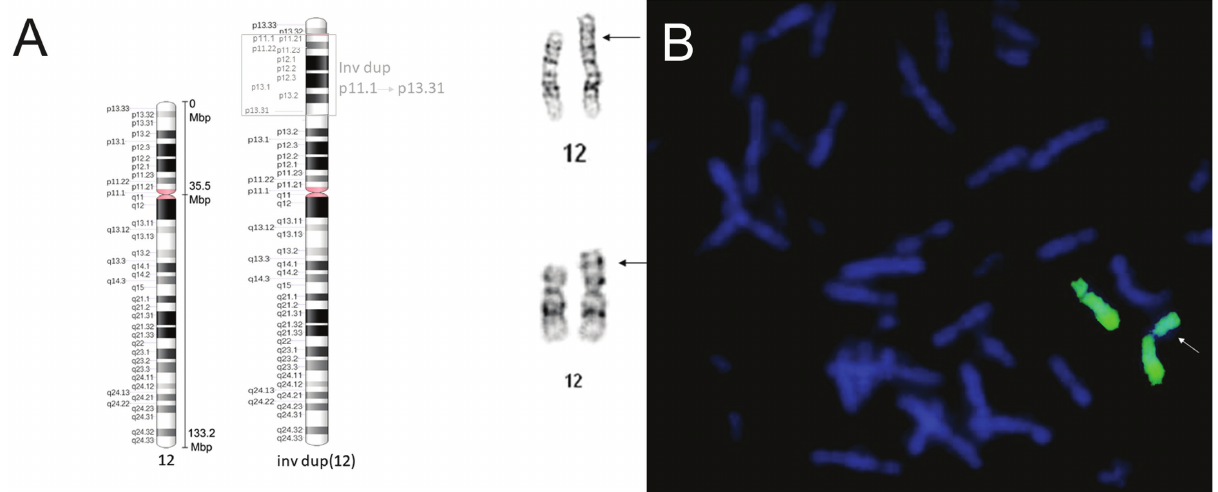
Figure 2 - Chromosome 12 karyotyping and FISH. (A) GTG-banded karyotype of patient showing the normal and duplication and inversion paracentric 12p.(B)FISHmetaphaseusingWCPprobeforchromosome12of CYTOCELL AQUARIUS®OxfordGeneTechnologyindicatingadifferenceinsizein one of the patient’s homologous chromosome, the arrow indicates the duplication 12 p.